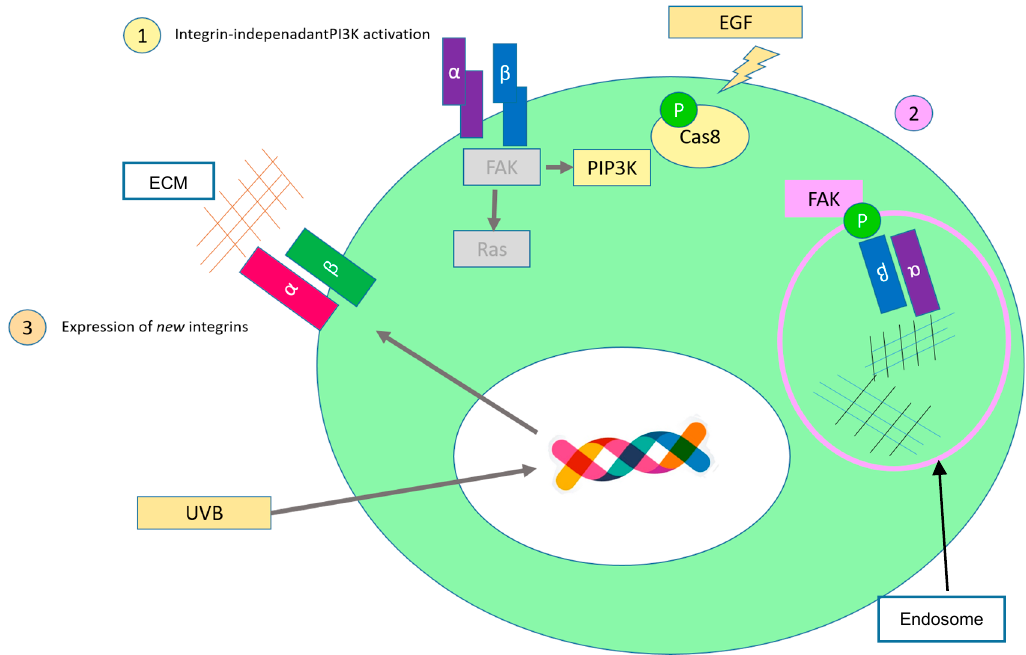
Figure 4. Schematic representation of some integrin-mediated mechanisms to avoid anoikis. (1) Growth factors can phosphorylate caspase-8 and this allows interaction and activation with PI3K; (2) Integrins are endocytosed and integrin signaling continues in the endosomes via interaction with FAK; (3) Integrins that are not expressed in a specific tissue are upregulated. These integrins can bind to new components of the extracellular matrix (ECM) and start signaling. (Of note, the DNA cartoon was designed by Freepik). Big ellipse in green: cell; small ellipse in white: nucleus.